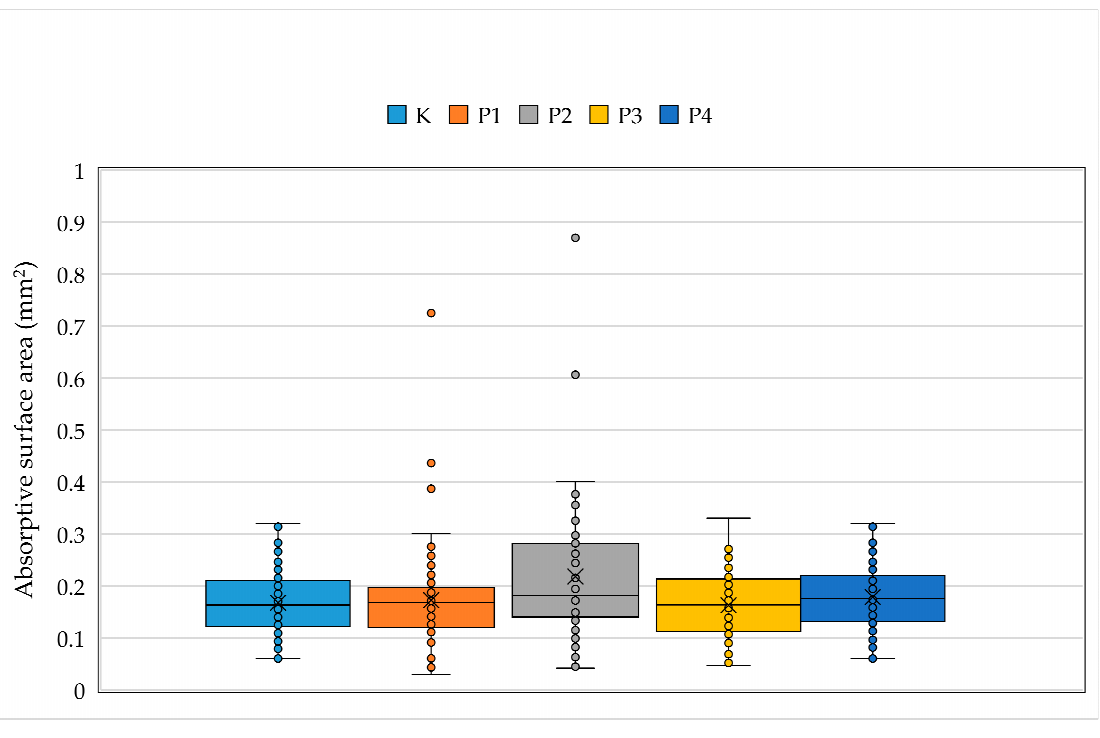
Figure 6. The average absorptive surface area of duodenal villi according to the group of broiler chickens on the 42nd day of the feeding trial (Kruskal–Wallis test, p < 0.001).